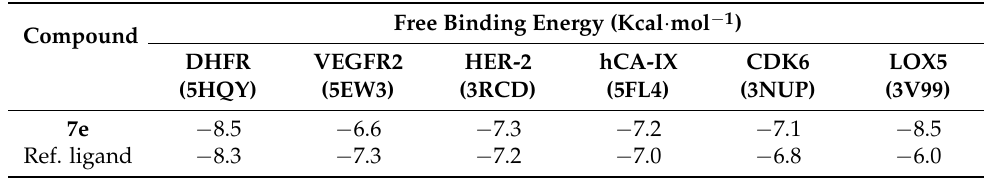
Table 2. Free binding energy (Kcal · mol − 1) of top-ranked active compound, 7e , with the active site of different anticancer drug targets studied using AutoDock 4.2